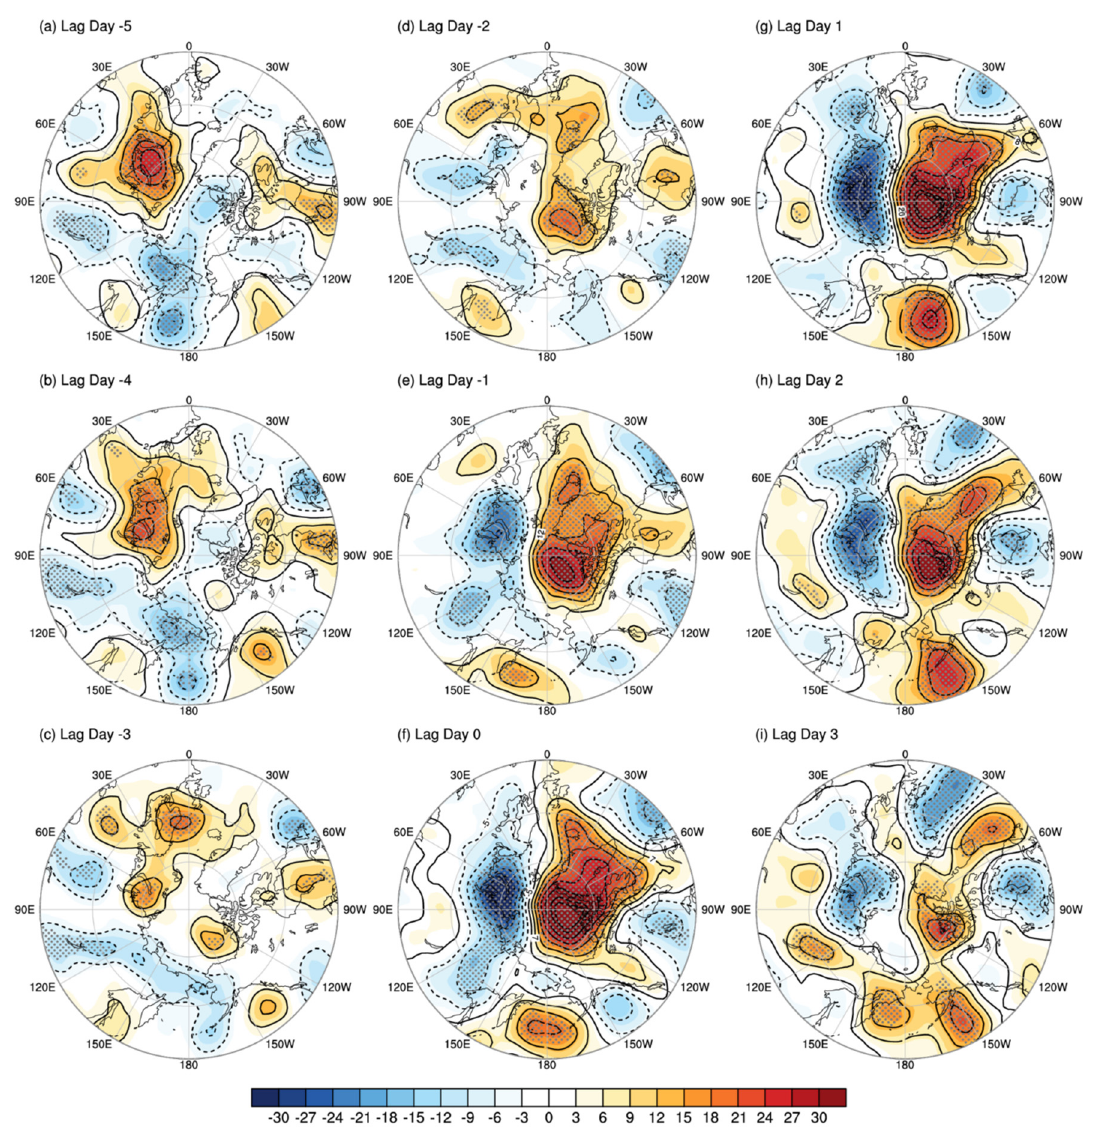
Figure 7. Composite daily evolutions in the synoptic-scale 500-hPa geopotential height (H500) anomalies (gpm) from − 5 to +3 days ( a – i ) for 114 best-matching events of the SOM3. The dots denote the grids, where the anomalies were statistically significant at a 5% level as per the two-sided Student’s t -test.